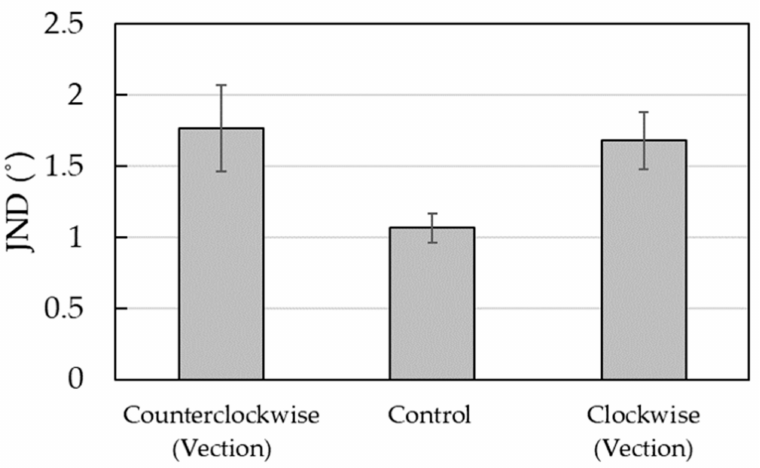
Figure 3. Average JNDs and standard